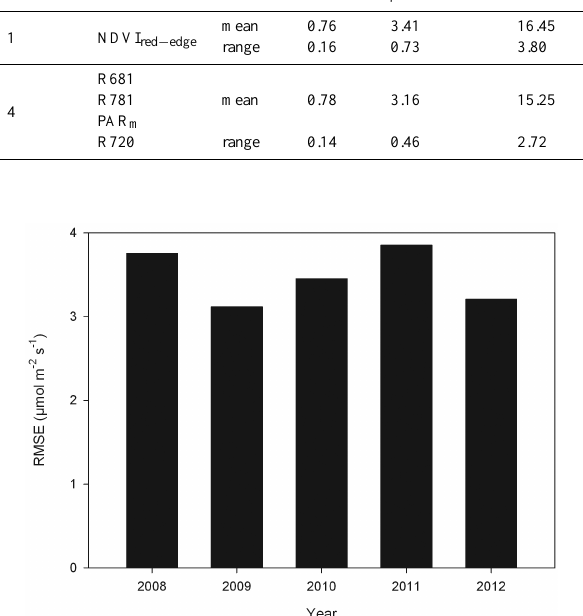
Figure 6. Root mean square error (RMSE) of the validated mod- els based on the red-edge normalized difference vegetation index (NDVI red-edge )